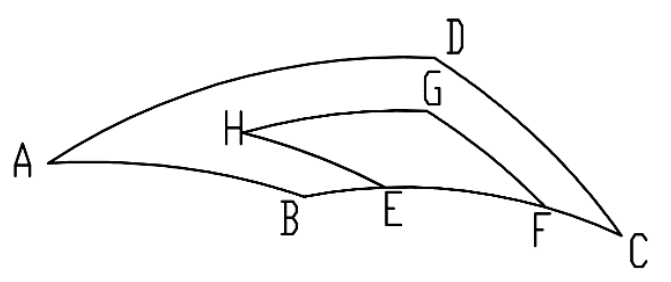
Figure 2. Computational domain geometry model.